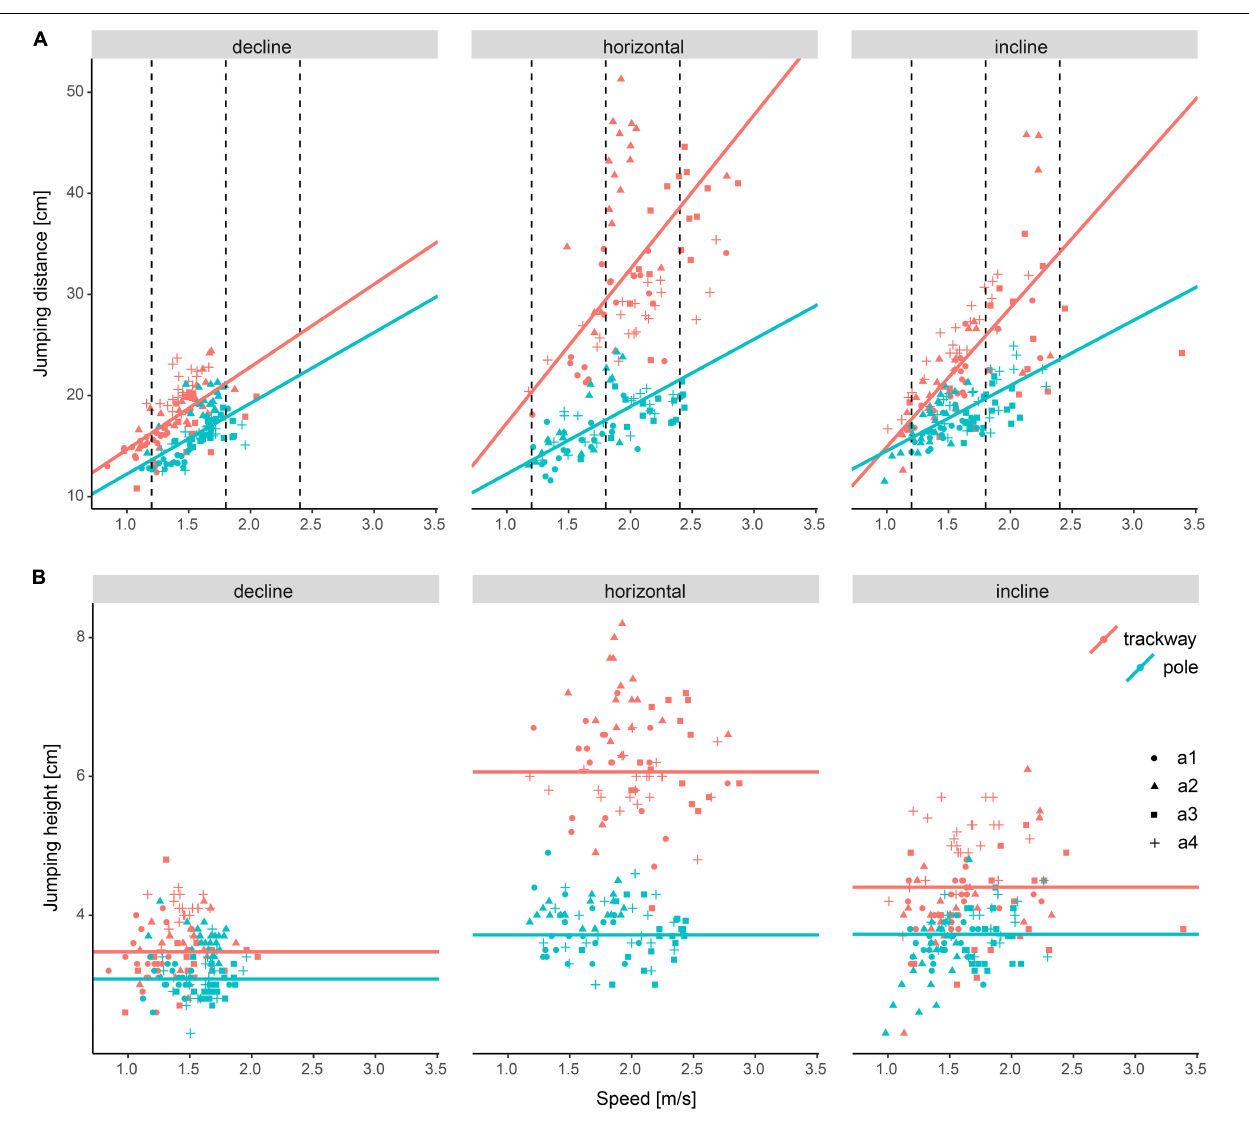
FIGURE 4 | Differences in jumping distance and jumping height among experimental setups. (A) Jumping distance and (B) Jumping height. Dashed lines indicate the speed values at which setups were compared statistically post hoc (not relevant for jumping height as speed had no significant effect and hence was removed from the final regression model). a1–a4 refer to the studied